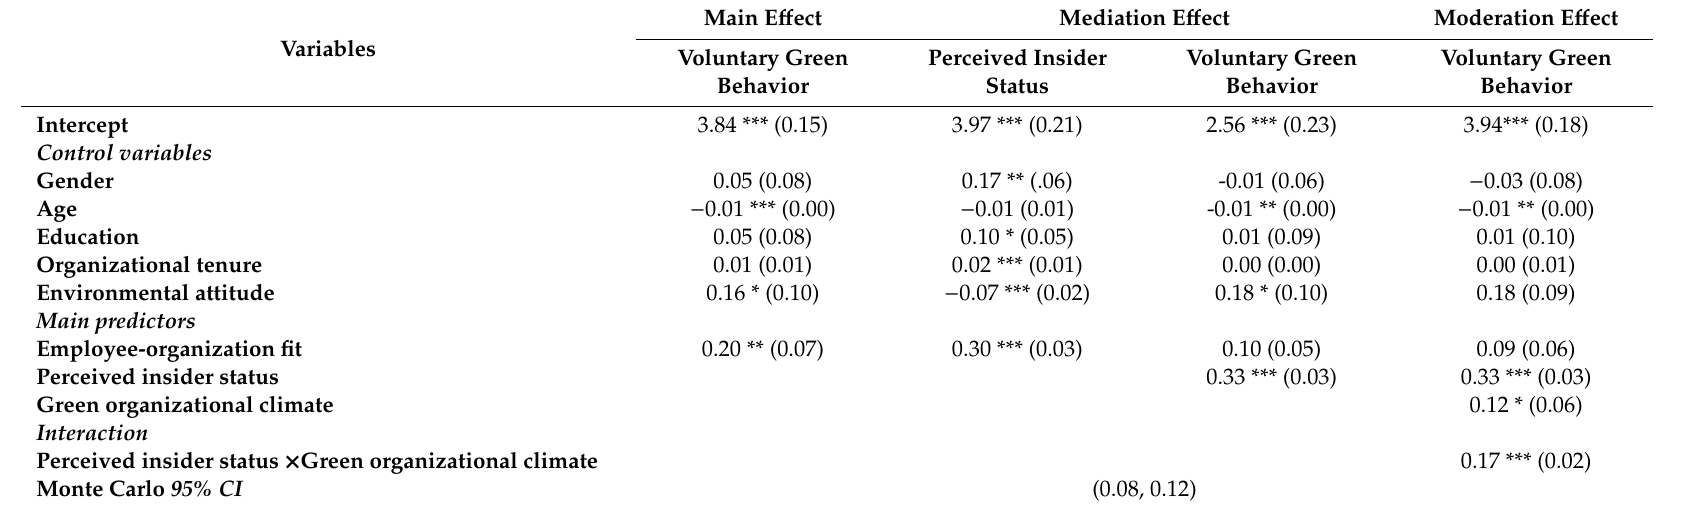
Table 3. Mplus path analysis